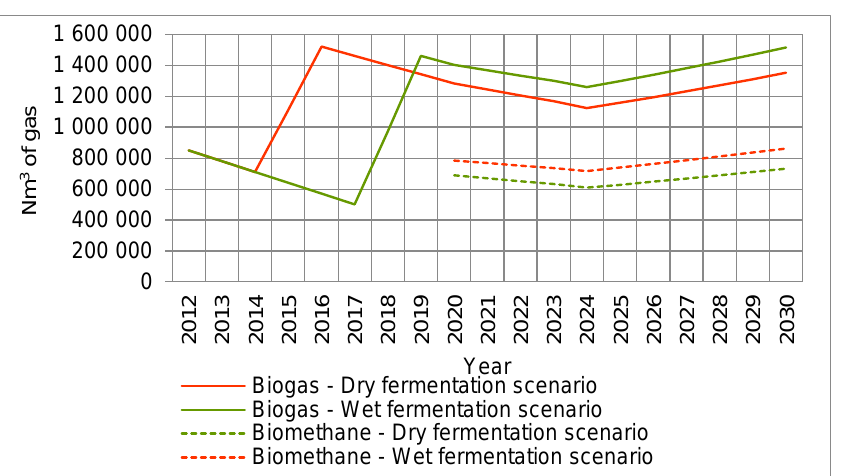
Fig. 2. Biogas and biomethane production potential in